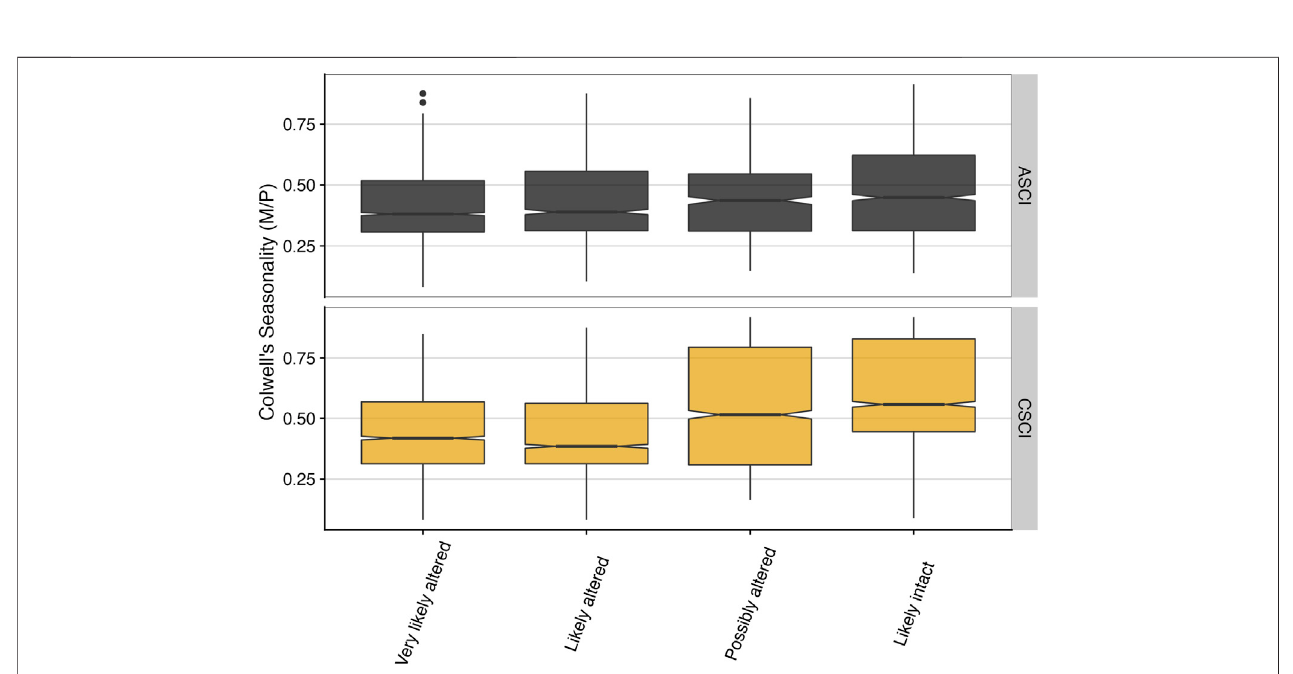
FIGURE 7 | Colwell ’ s seasonality versus binned ASCI and CSCI values (based on thresholds from Mazor et al. (2016) and Theroux et al. (2020) for all paired sites across California. Notches indicate an approximate 95% con fi dence interval to compare medians, where if notches of two boxplots do not overlap, this suggests the medians are signi fi cantly different (see McGill et al.